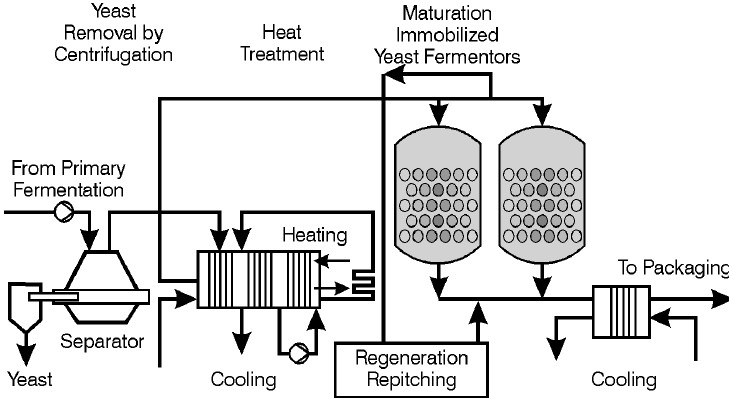
Figure 15. Cultor’s two hour continuous maturation system [108].